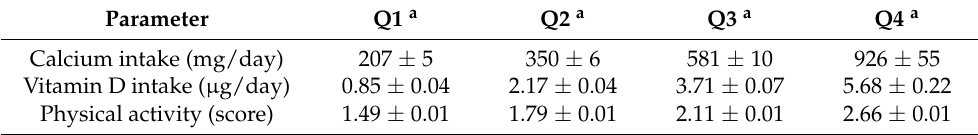
Table 3. Quartile values of dietary calcium, vitamin D, and physical activity.